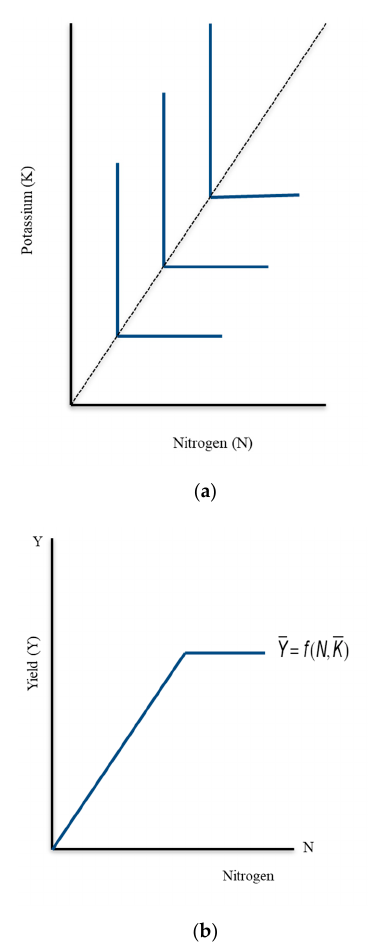
Figure 1. Isoquants under Leontief technology ( a ); Yield response under Leontief technology ( b ).